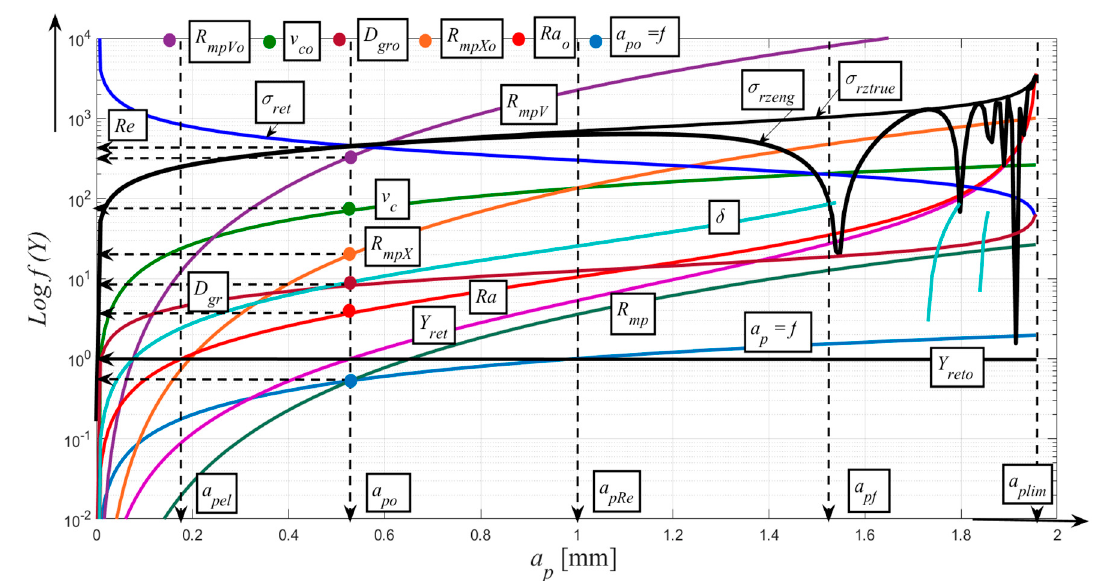
Figure 3. The relation R mp for EN S235JRG1 material, where a pel is the depth of cut at the elasticity limit, a p0 is the depth of cut at the neutral plane, a pRe is the depth of cut at the elastic limit, a pf is the depth of cut at the failure limit, and a plim is the limit depth of cut.